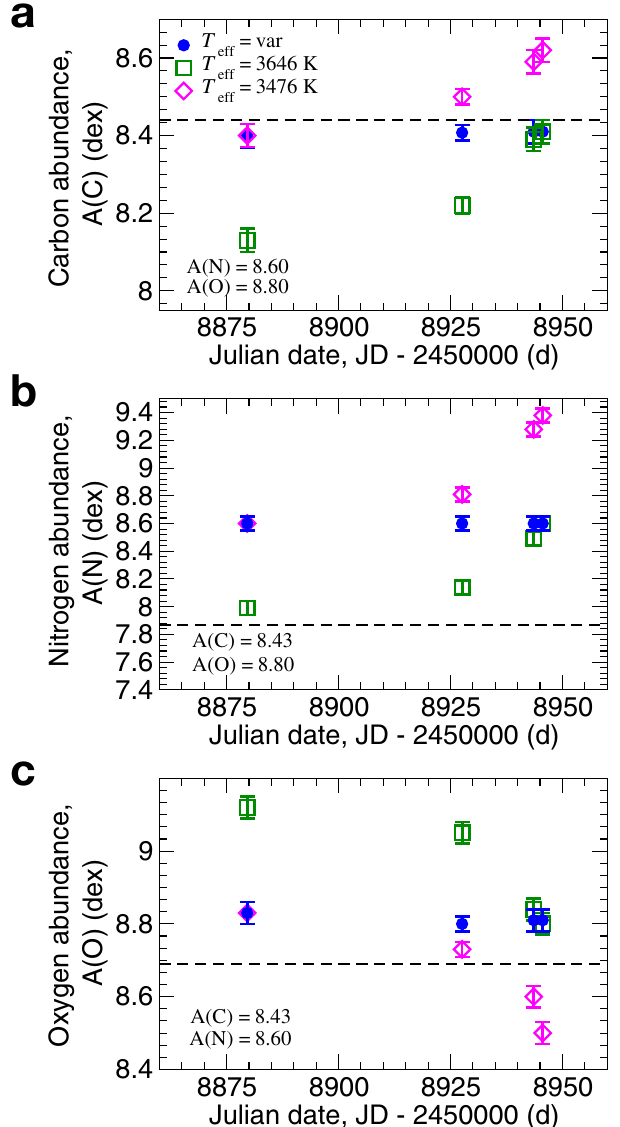
Fig. 3 Conditional chemical abundances of carbon, nitrogen, and oxygen in the atmosphere of Betelgeuse at four different epochs: 31-01-2020, 19-03-2020, 04-04-2020, and 06-04-2020. Chemical abundances of carbon, nitrogen, and oxygen are calculated under three scenarios. First scenario is effective temperature T eff = var, the chemical abundances are obtained at parameters according to Table 1 (blue fi lled circles). Second scenario is the chemical abundances are obtained at the assumption of constant effective temperature T eff = 3646 K and log g = 0.2 (green open squares). Third scenario is the chemical abundances are obtained at the assumption of constant effective temperature T eff = 3476 K and log g = 0.2 (pink open diamonds). a Carbon abundances calculated under three scenarios. b Nitrogen abundances calculated under three scenarios. c Oxygen abundances calculated under three scenarios. The dashed lines show solar abundances obtained in this study. Error bars represent standard deviation. Source data are provided as a Source Data fi